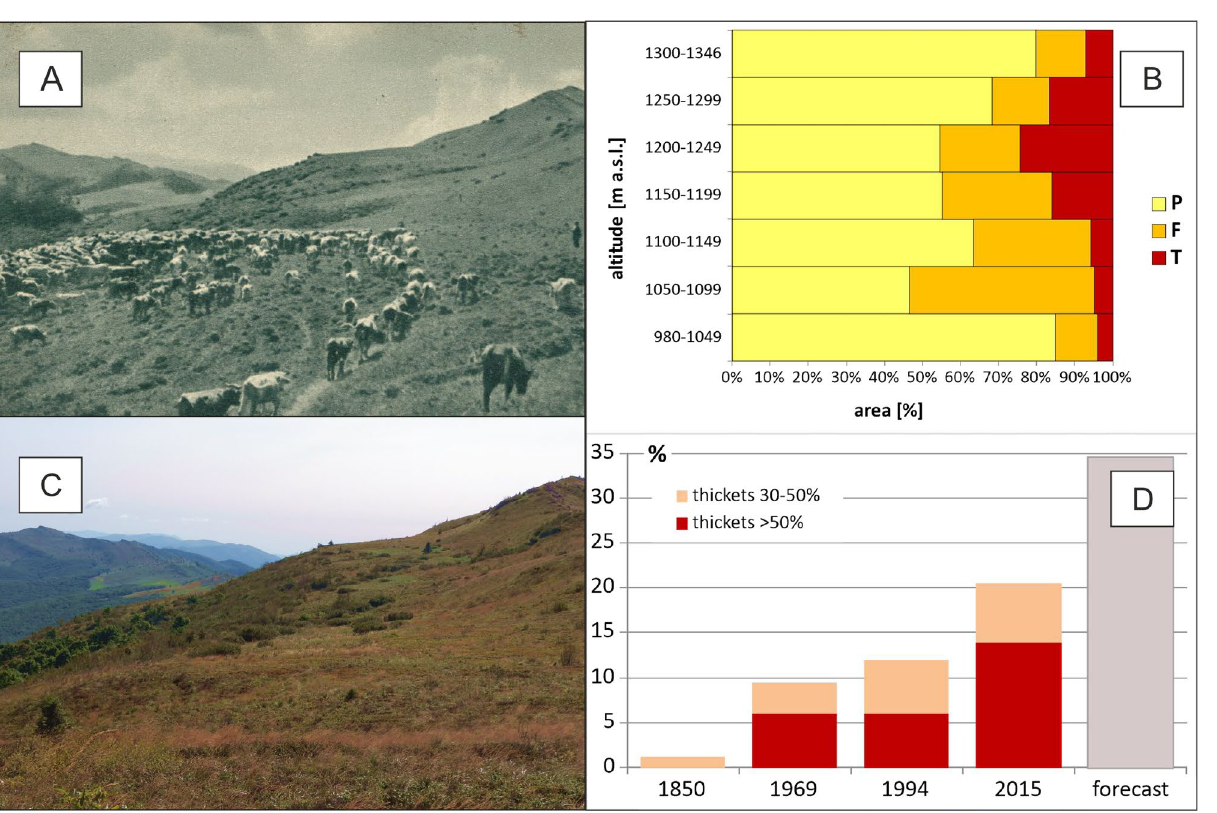
Figure 6. The present and historical extent of subalpine thicket and expected growth. ( A ) Vegetation cover in Rozsypaniec ridge in 1930’ Photo credit: Public domain, source: https:// polona. pl/ item/ widok- na- halicz- w- powie cie- turcz anskim- 1335-m- n-p- m,Njg2N jY1NTY/ 0/ #info:metadata; (B) vegetation types in altitudinal limits in 2015: open meadow (polonina)—P; subalpine thicket (present)—T, subalpine thickets (forecast)—F. See also Supplementary Information—Appendix. ( C ) Vegetation cover at present (2015), photo credit: S. Kucharzyk; ( D ) Dynamics of thicket cover. Source : 1850 (Kucharzyk & Augustyn, 2008), 1969 (Kucharzyk,